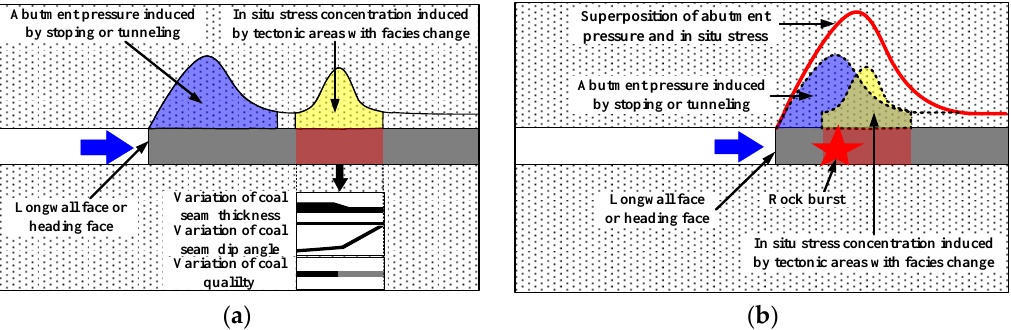
Figure 11. Schematic of the rock burst mechanisms induced by tectonic areas with facies changes, ( a ) before superposition of the abutment pressure and in-situ stress, ( b ) superposition of the abutment pressure and in-situ stress.